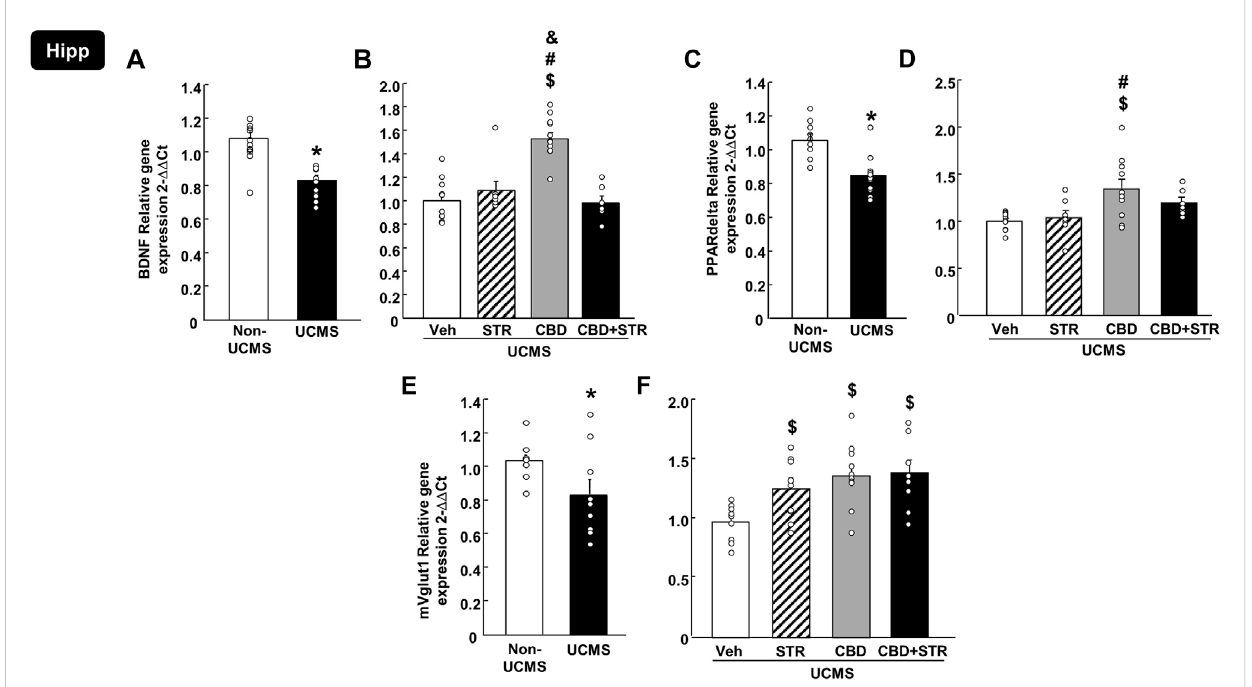
FIGURE 6 Relative gene expression of brain-derived neurotrophic factor (BDNF), peroxisome proliferator-activated receptor delta (PPARdelta) and vesicular glutamate transporter 1 (mVglut1) in the hippocampus (Hipp) of mice exposed to the UCMS and treated with CBD, STR or their combinationbyreal-timePCR .Columnsrepresentthemeansandverticallinesthe±SEMoftheBDNF(panels A,B ),PPARdelta(panels C,D )andmVglut1 (panels E, F ). *Values from the VEH-treated UCMS group that differ signi fi cantly from VEH-treated non-UCMS group (Student ’ s t-test, p < 0.05). $ Values from STR-, CBD- and/or CBD + STR-treated UCMS mice that were different from VEH-treated UCMS mice. # Values from CBD- and/or CBD + STR-treated UCMS mice that were different from the STR-treated UCMS group. and Values from CBD-treated UCMS mice that were different from CBD + STR treated UCMS mice (One-way ANOVA followed by Student-Newman-Keuls, p <